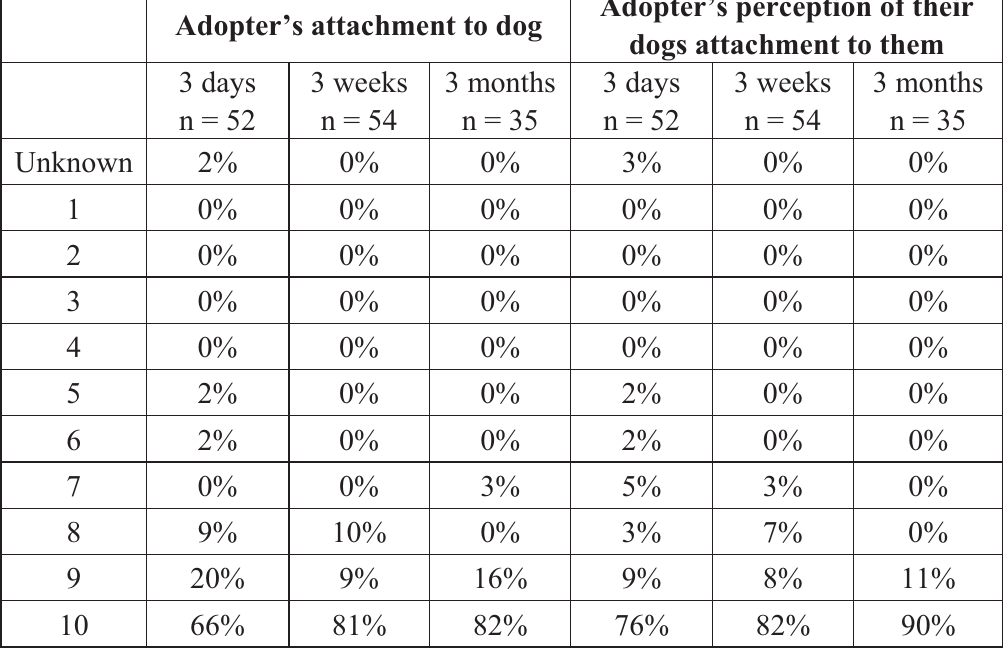
Table 5. Responses to the two questions “On a scale of 1–10, with 10 being the most attached: how attached are you to your dog?” and “how attached is the dog to you?